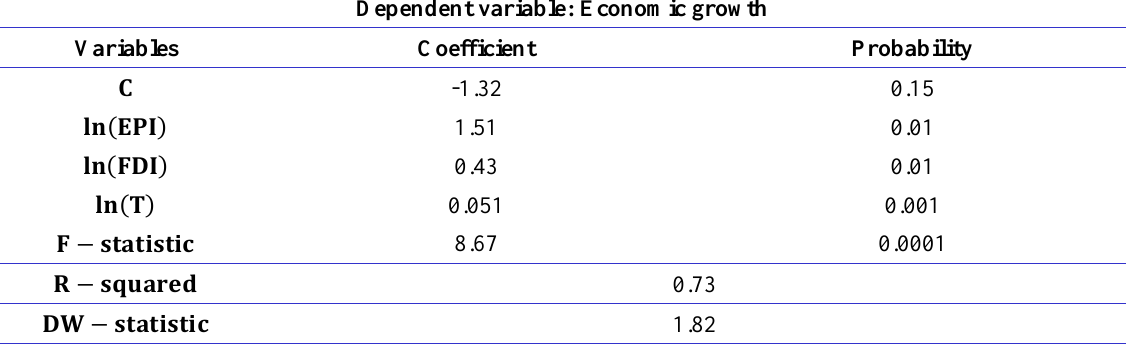
Table 4. Results of long-run model calculation Dependent variable: Economic